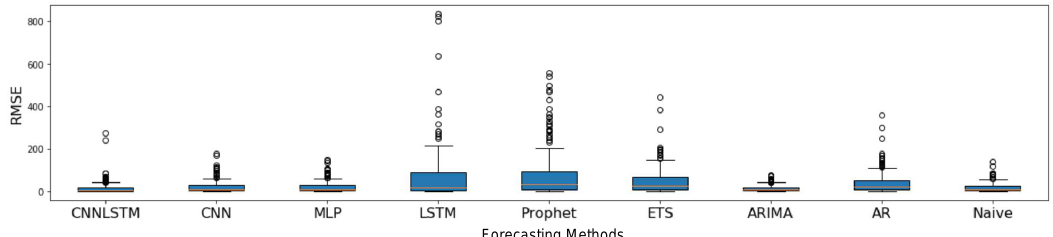
Figure 10. Two different types of cells with very different mobile activity patterns. The cell in ( a ) has a periodic, regular pattern, whereas the cell in ( b ) has an irregular pattern containing local and global trends with activity levels going up and down.